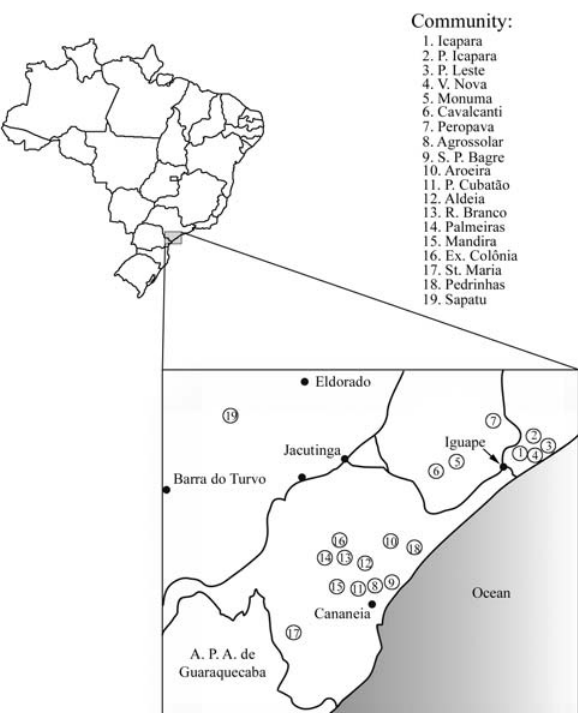
Figure 1 - Map of Brazil showing the 19 communities in the Vale do RibeirainSãoPaulostatewherethe78sweetpotato( Ipomoeabatatas )ac- cessions (landraces and putative clones) were